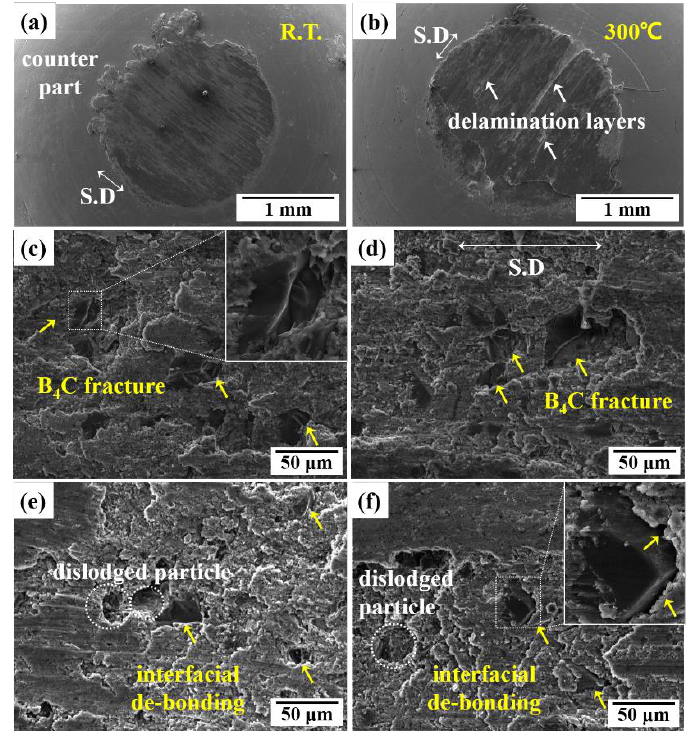
Figure 6. SEM images of the counter materials (steel pin) at ( a ) room temperature, ( b ) 300 °C, and worn surface of the composite after wear test at ( c )room temperature, ( d ) 100 °C, ( e ) 200 °C, and ( f ) 300 °C.